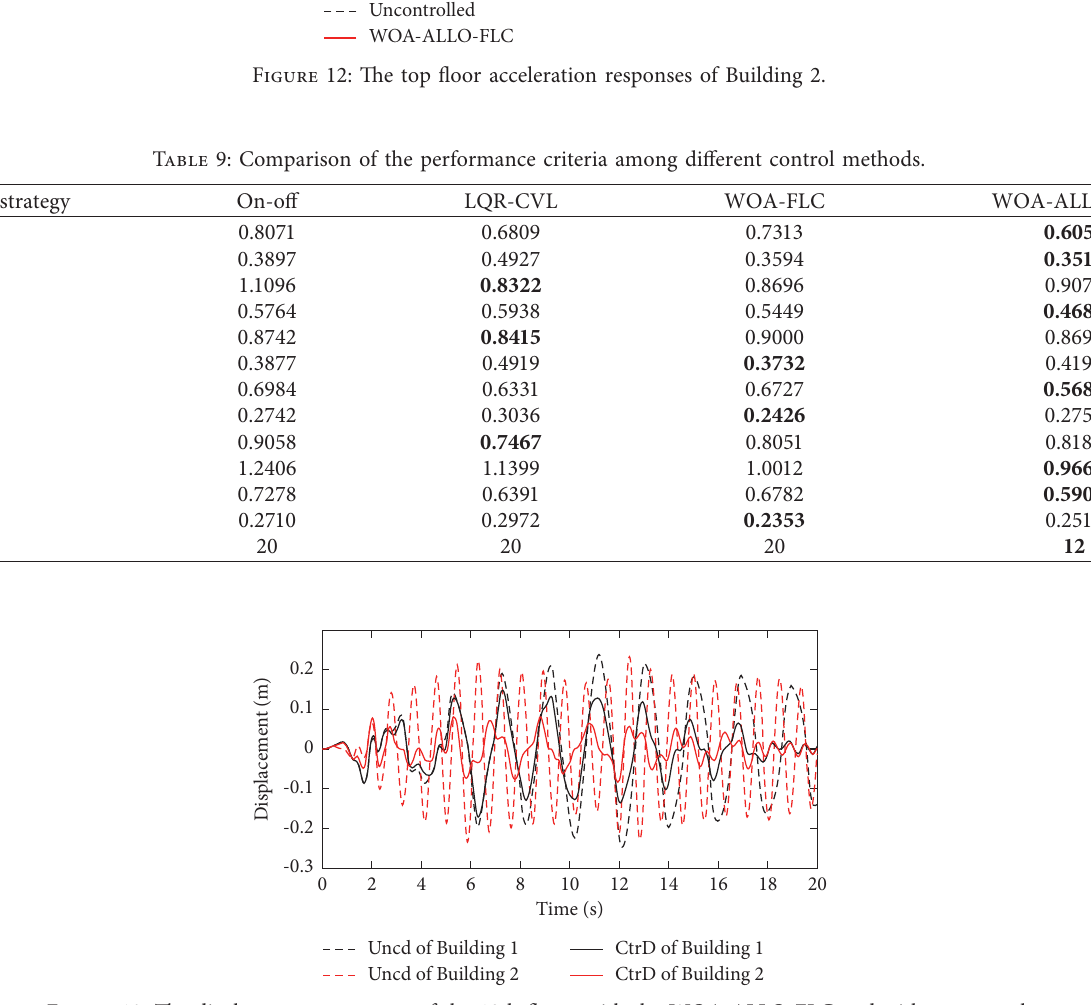
Figure 13: The displacement responses of the 10th floors with the WOA-ALLO-FLC and without control.